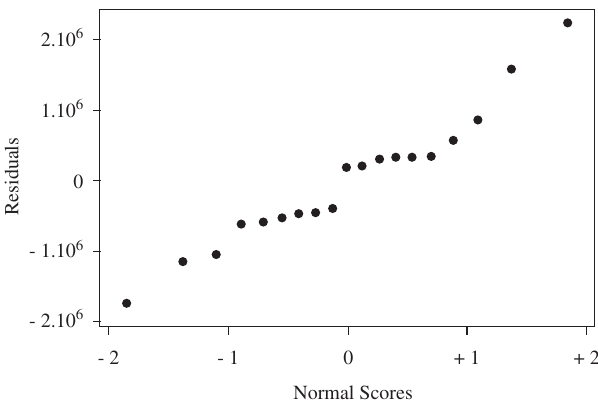
Figure 5. Graph of residuals against normal scores values for rolled notch testpieces.